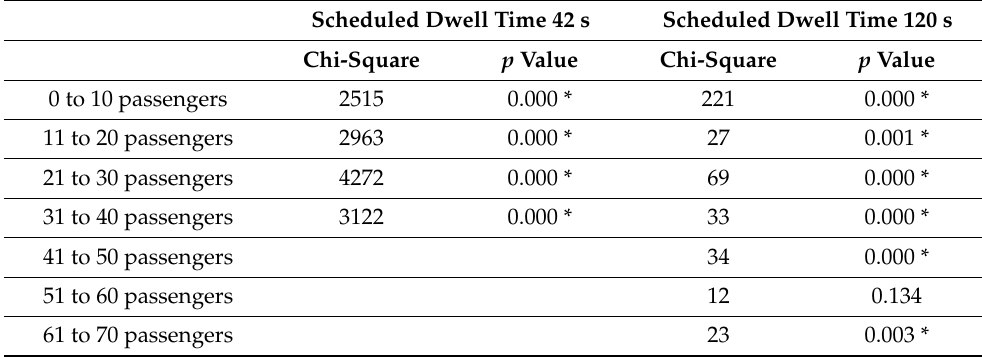
Table 2. Chi-square goodness of fit test results. Significant results indicated with an *, significance level p < 0.05.